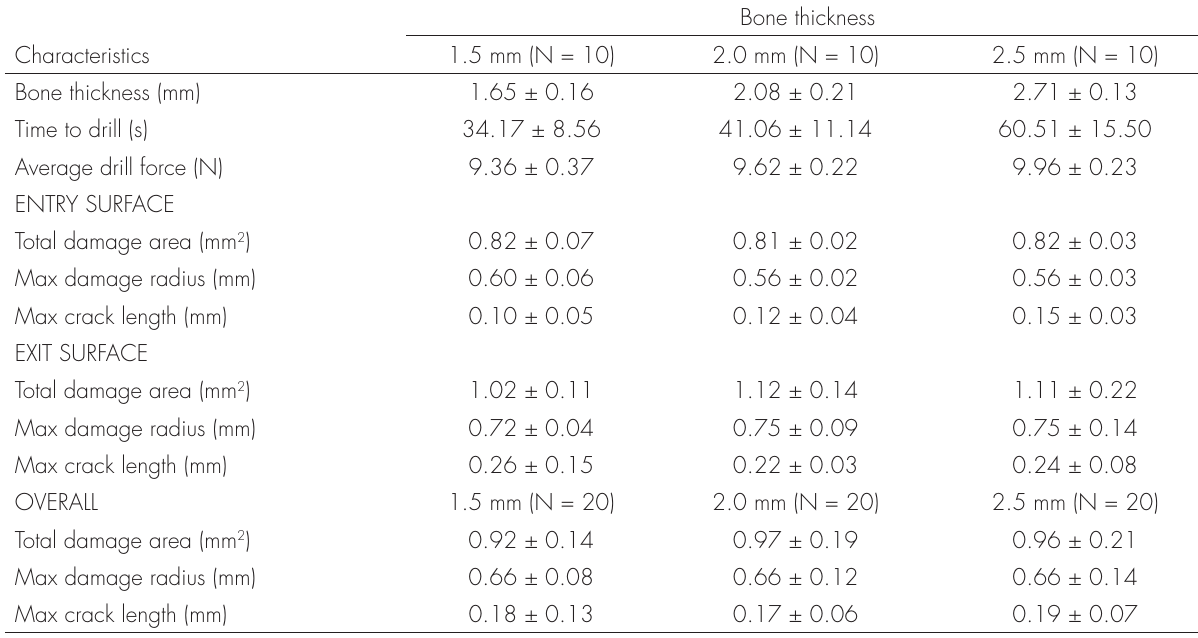
Table I. Characteristics of bone block specimens of varying thicknesses